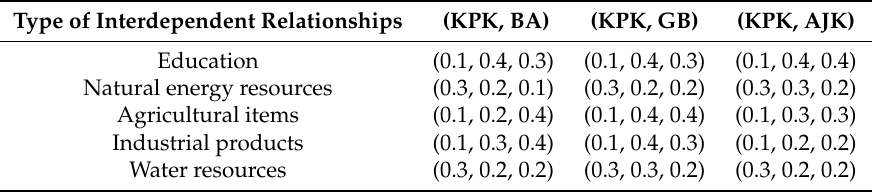
Table 4. IN set of interdependent relationships between KPK and other provinces. Type of Interdependent